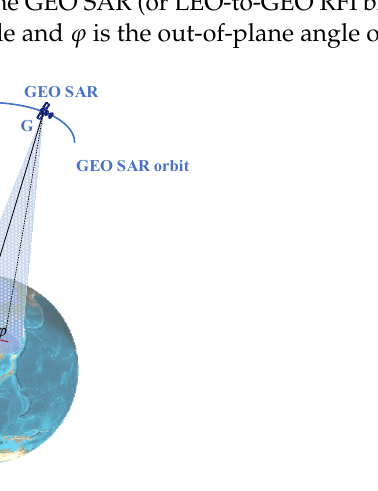
Figure 1. Schematic diagram when a GEO SAR and a LEO SAR observe the same target.